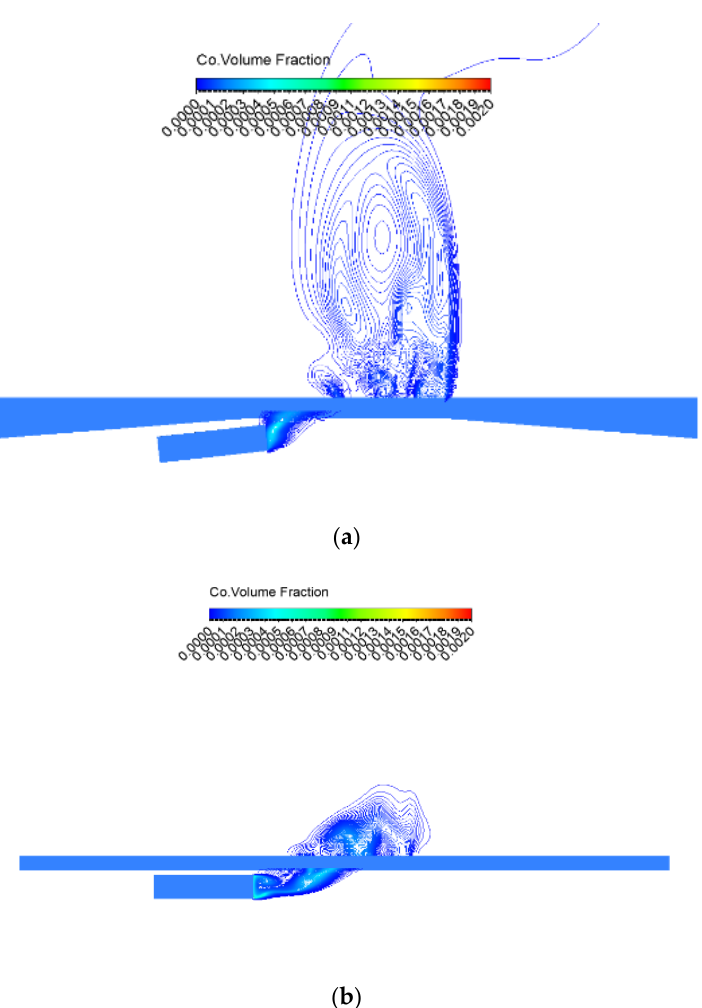
Figure 8. CO diffusion simulation when the bus leaves the station: ( a ) diffusion simulation of CO emission at bus bay stop, ( b ) diffusion simulation of CO emission at curbside bus stop.